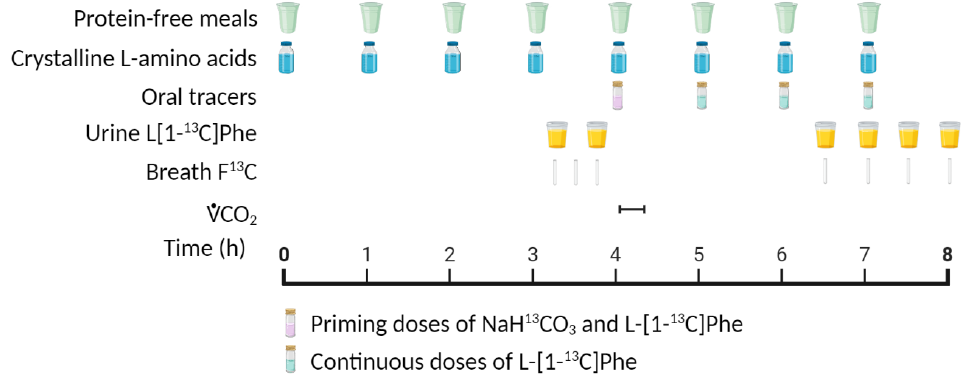
Figure 2. Example protocol for an indicator amino acid oxidation (IAAO) study. Created with Bio- Render.com.